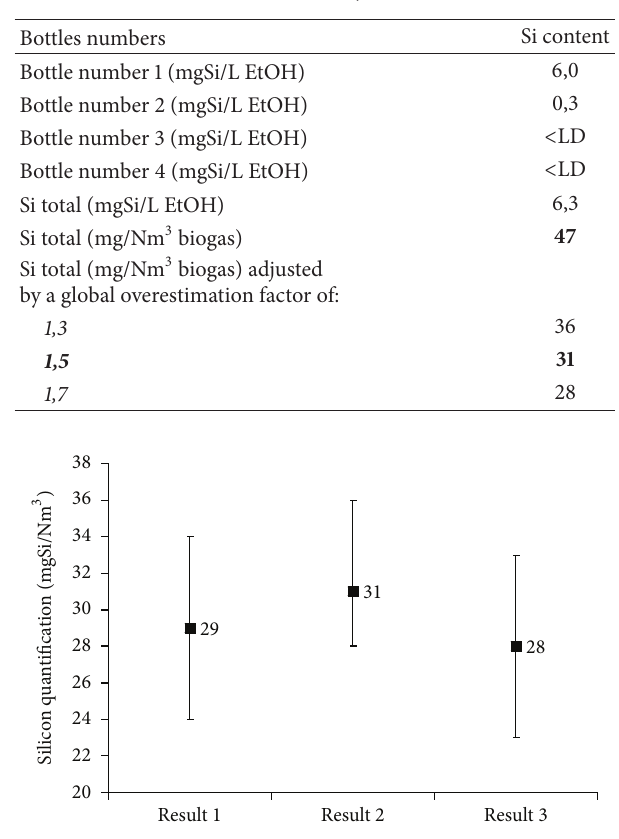
Figure 4: Comparison of experimental quantifications obtained by GC-MS ( Result 1 ); ICP-OES ( Result 2 ); and the theoretical ICP-OES by calculation ( Result 3